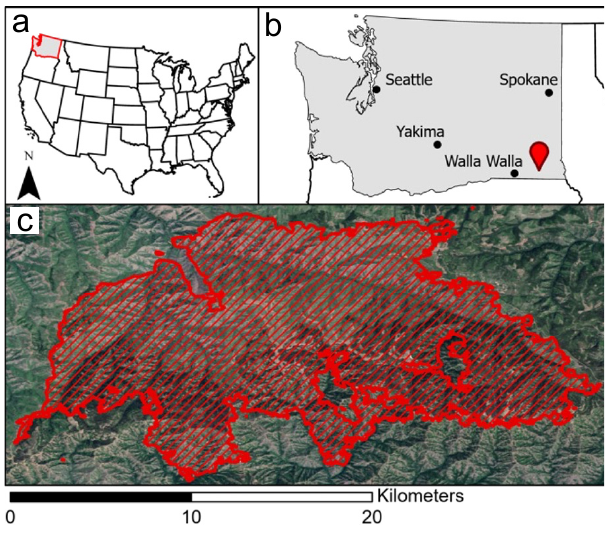
Figure 3. Green Ridge fire location. ( a ) Washington, USA. ( b ) Red pin indicates the fire location in southeastern Washington. ( c ) Cross-hatched area indicates one of the last infrared-captured fire perimeters for the Green Ridge fire, on 12 September 2021.